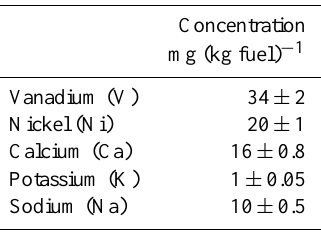
Table 2. Elemental composition of a fuel sample delivered by the chief engineer of Stena Line.